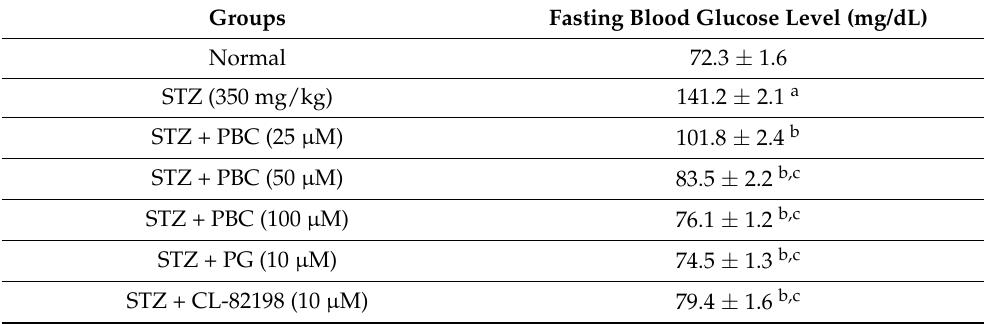
Table 1. Effect of PBC in STZ-induced fasting blood glucose